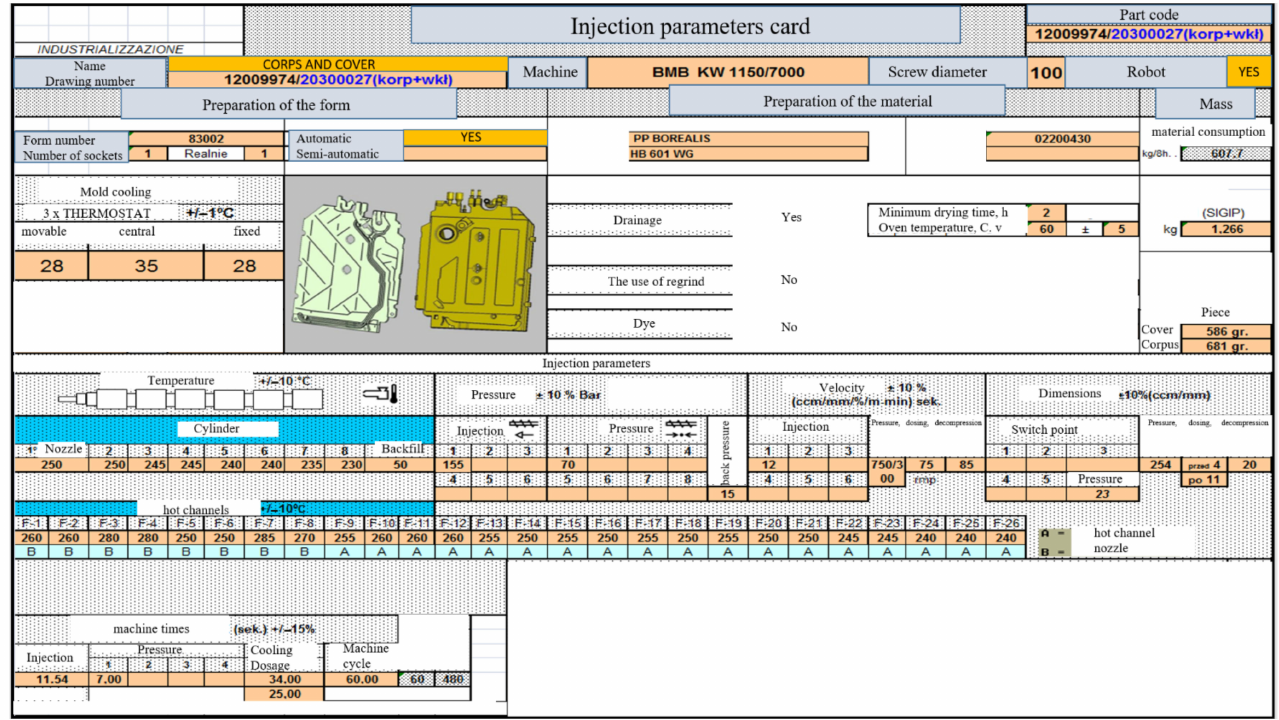
Figure 21. Injection parameters card—moldings of the body and cover of the